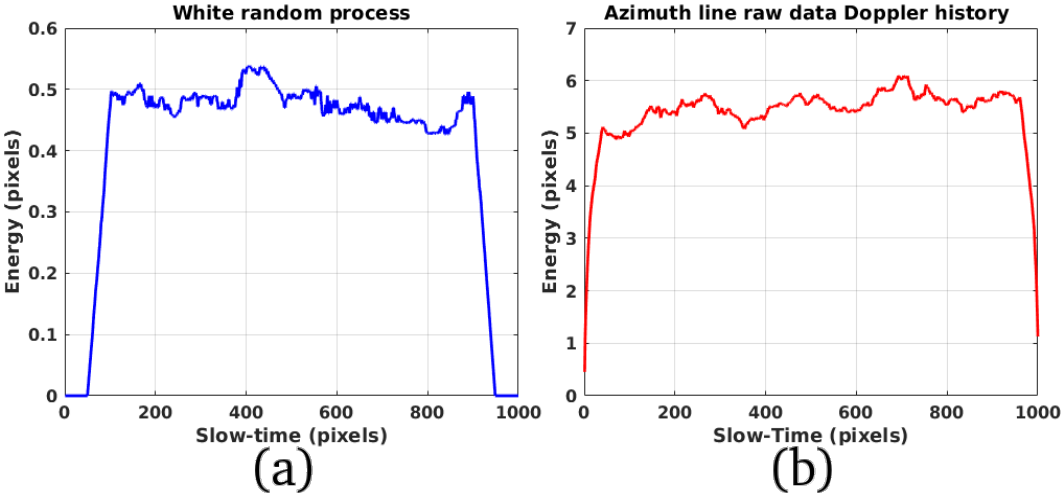
Figure 4. ( a ): Spectrum of the white random process. ( b ): spectrum of the CSK raw Doppler